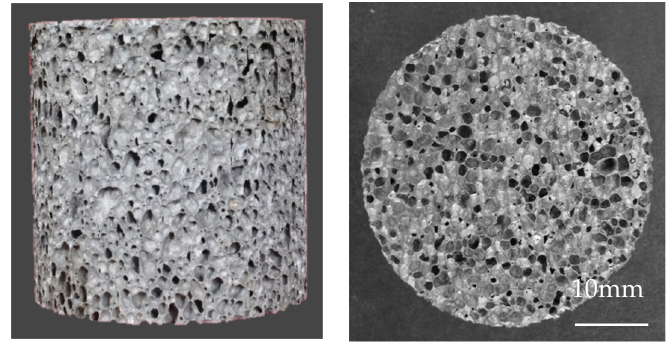
Figure 1. The closed-cell Al foam specimen for impact testing.